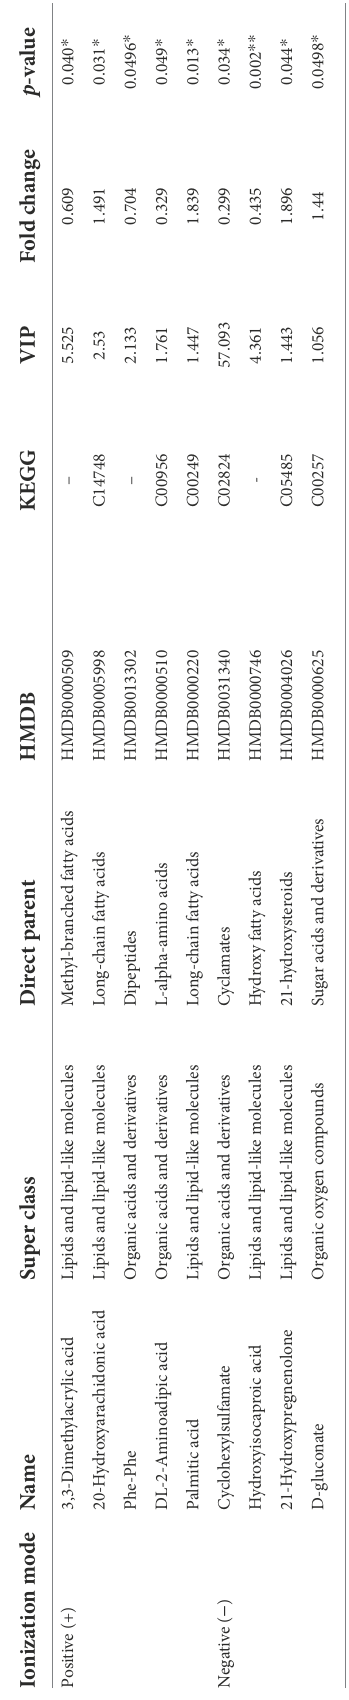
The relationships between the gut microbiota and differential metabolites during full-term pregnancy were assessed by Pearson correlation analysis. We found that the relative abundance of Proteobacteria was positively correlated with the level of hydroxyisocaproic acid, whereas the abundance of identified genera of Firmicutes was correlated with the levels of 3,3-dimethylacrylic acid and phenylalanylphenylalanine (Supplementary Figure S7; Supplementary Table S4). The concentration of caprylic acid in plasma was positively correlated with the level of palmitic acid in fecal samples, indicating that these core metabolites might be important mediators involved in full-term pregnancy. Additionally, the level of 20-hydroxyarachidonic acid in the fecal samples was negatively correlated with the plasma metabolites L-norleucine, DL-phenylalanine and L-valine (Supplementary Table S5). The plasma metabolites-M795T29 (a substance similar to sunitinib in structure) and bisindolylmaleimide I, which are the derivatives of indoles, could be potential regulators that mediate interactions between the digestive tract and circulation (Figure